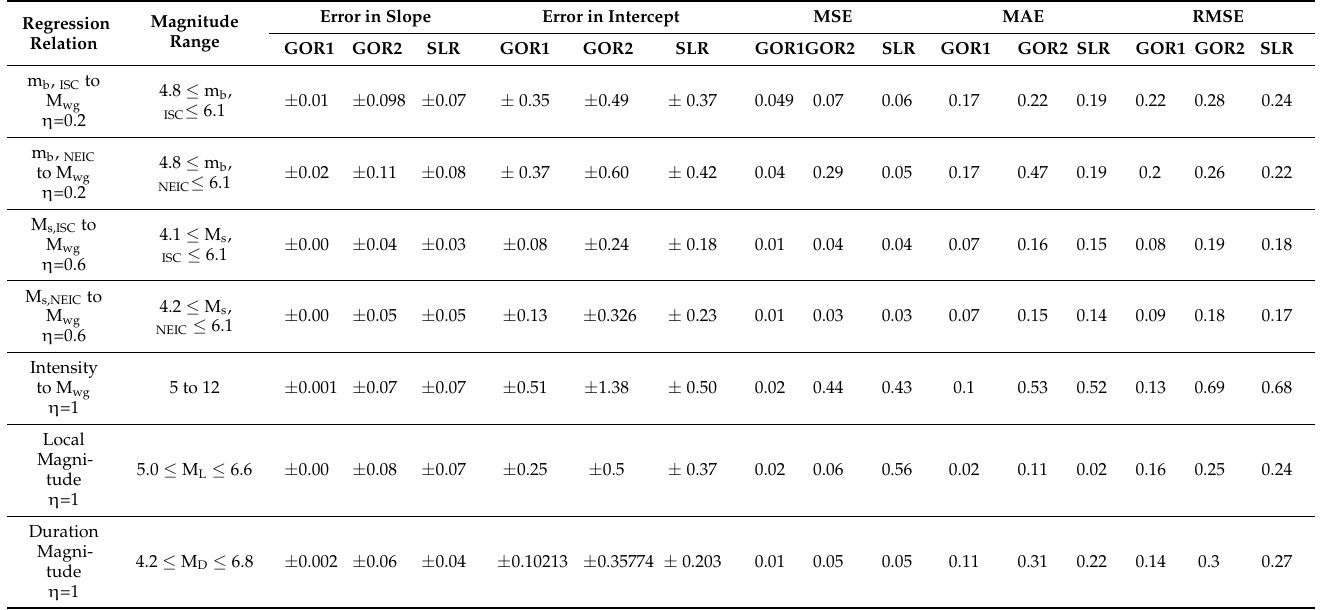
Table 3. The list of error metrics for regression parameters such as Error in Slope, Error in intercept, Mean Square Error, Mean Average Error, and Root Mean square Error corresponding to the derived regression relations for this study